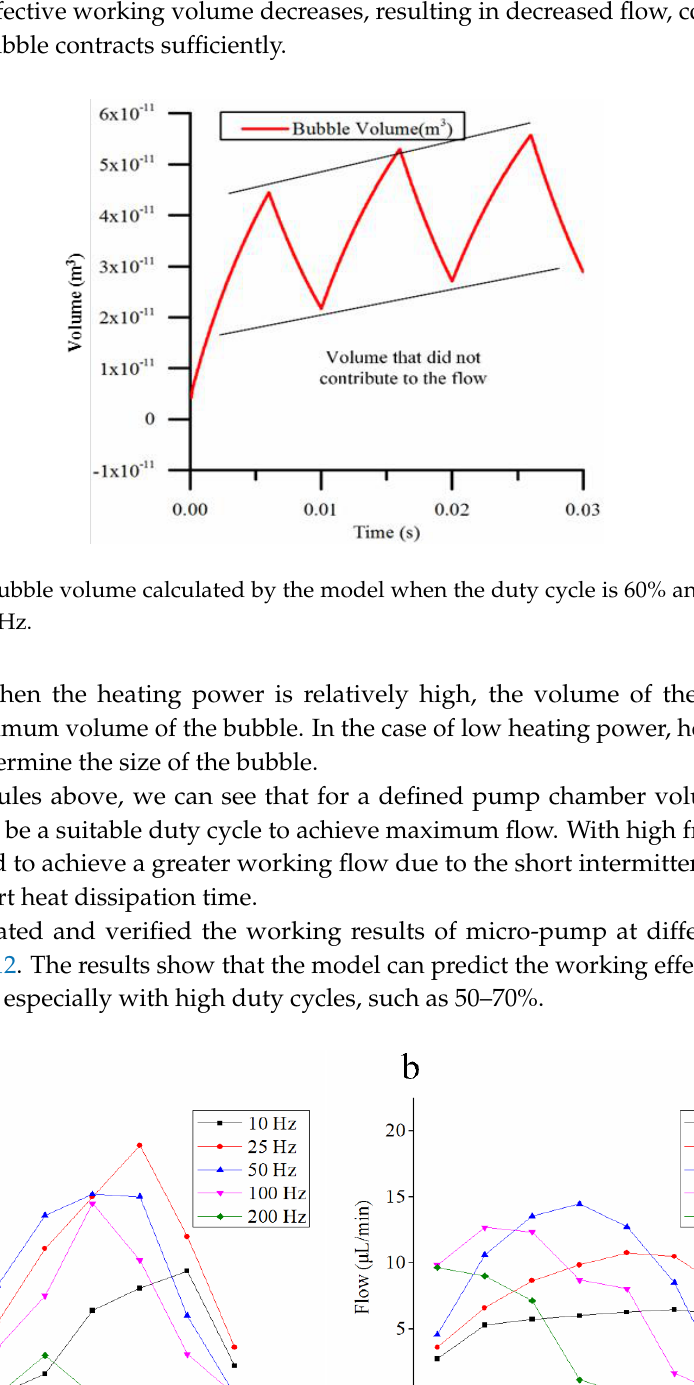
Figure 10. The volume of bubble calculated by the model when the duty cycle is 20% and the heating frequency is 25 Hz.